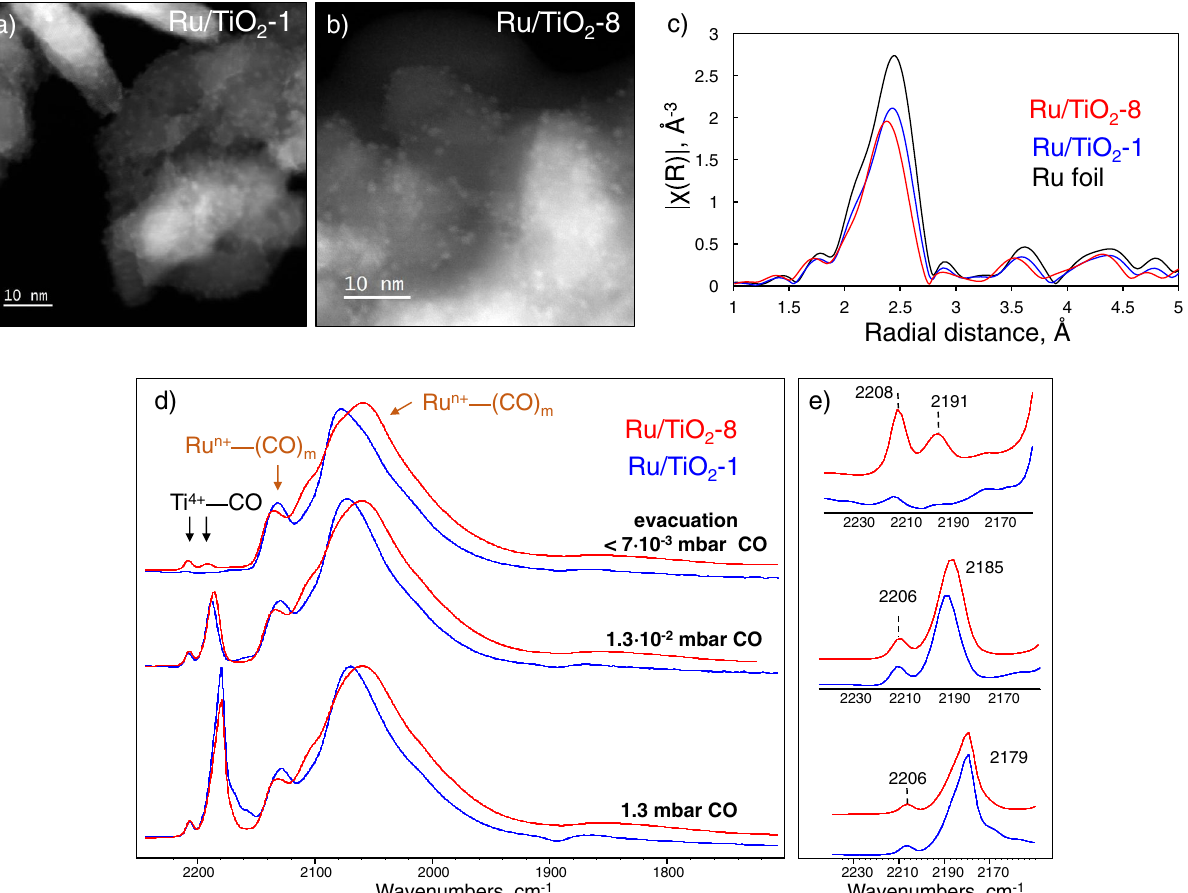
Fig.1|Catalystcharacterization.a , b STEMimagesofRu/TiO 2 -1andRu/TiO 2 -8,respectively; c EXAFSspectraoftwosamplesandRufoilstandard; d FTIRofadsorbedCO at − 296°C at different CO pressures; e Zoom in of the 2240 – 2150cm − 1